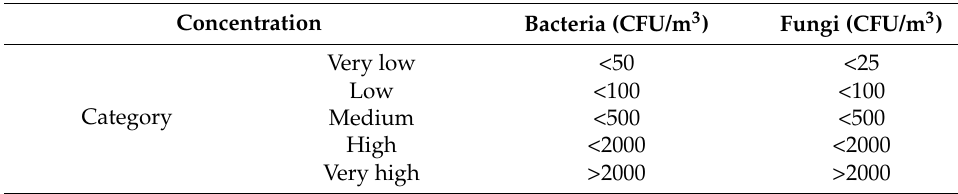
Table 1. Criterion of the concentration of mixed population of bacteria and fungi in the air of occupied rooms [58]. Concentration Bacteria (CFU/m 3 ) Fungi (CFU/m 3 ) Very low <50 <25 Low <100 <100 Category Medium <500 <500 High <2000 <2000 Very high >2000